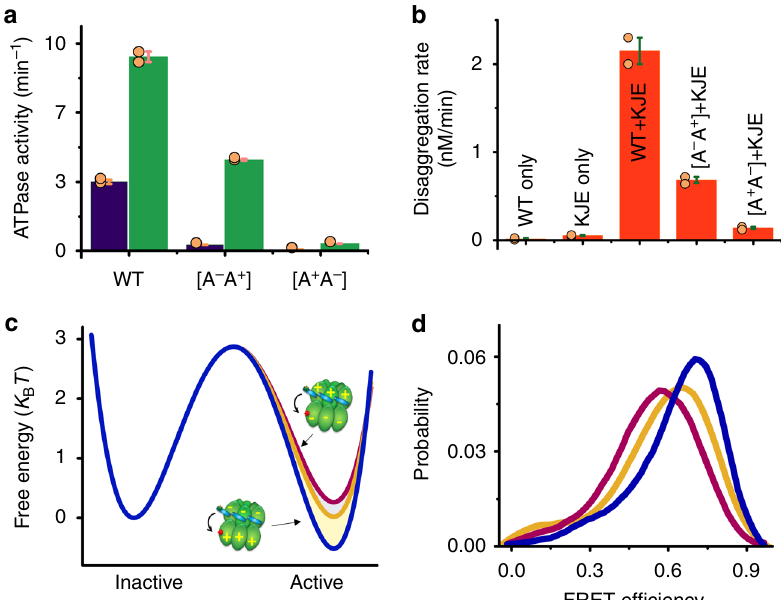
Fig. 3 Nucleotide binding sites affect M-domain dynamics. a Basal and κ -casein stimulated ATPase activities (in purple and green, respectively) of the WT ClpB and the two nucleotide binding site mutants, [A − A + ] and [A + A − ]. The WT and [A − A + ] activities were enhanced signi fi cantly by κ -casein. b Disaggregation activity of ClpB WT and Walker A mutants. [A − A + ] retains a signi fi cant level of disaggregation activity, while [A + A − ] is less active. c Free-energy pro fi les of the M domain calculated from H 2 MM populations and rates as obtained from analysis of smFRET data of the WT (orange) and of [A − A + ] (blue) and [A + A − ] (purple). Barrier heights in this and other fi gures were calculated using the Arrhenius equation with a pre-exponential factor of 10 5 s − 1 . Transition rates (in s − 1 ) are given in Supplementary Table 4. State 1 of [A + A − ] is destabilized compared to the WT, and the transition rate from state 1 to state 2 is increased, while state 1 of [A − A + ] is stabilized, so that the transition rate from state 1 to state 2 is decreased (for the values of the ratio between states see Supplementary Table 5). d FRET ef fi ciency histograms of the WT (orange), [A + A − ] (purple), and [A − A + ] (blue). The shifts of the [A − A + ] and [A + A − ] histograms to higher and lower FRET ef fi ciency, respectively, re fl ect the stabilization or destabilization of state 1. Orange circles in ( a ) and ( b ) represent separate repeats of the measurements. Error bars represent standard errors of the mean. Source data are provided as